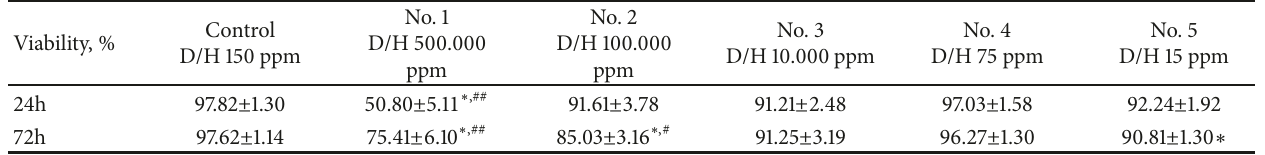
Table 3: ADSCs viability in growth media with different deuterium content. The results are expressed as mean ± SD (n=6), significant differences between the experimental group ∗ p < 0.05 compared to control, #p < 0.05 compared to group No. 1, and ##p < 0.05 compared to groups No. 2-5.).